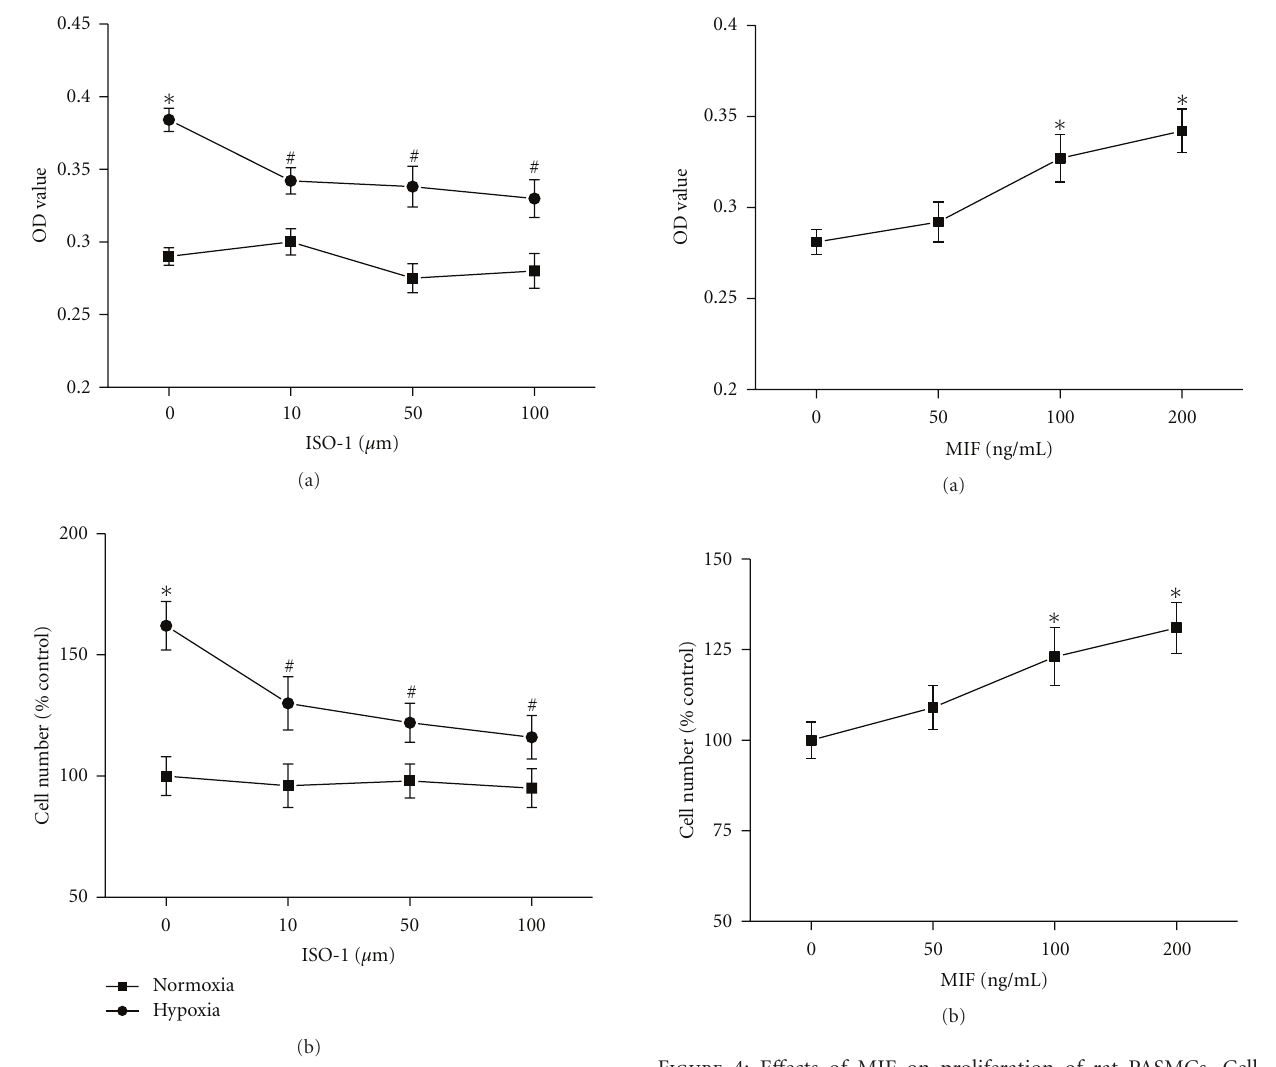
Figure 3: E ff ects of MIF inhibition on rat PASMCs proliferation under hypoxia exposure. PASMCs proliferation was measured by MTT (a) and direct cell counting (b). Hypoxia-induced PASMCs proliferation was inhibited by di ff erent concentrations of MIF antagonist ISO-1 (10, 50, 100 μ M). n = 6. ∗ P < 0 . 05 versus normoxic control; # P < 0 . 05 versus vehicle-treated hypoxia group.